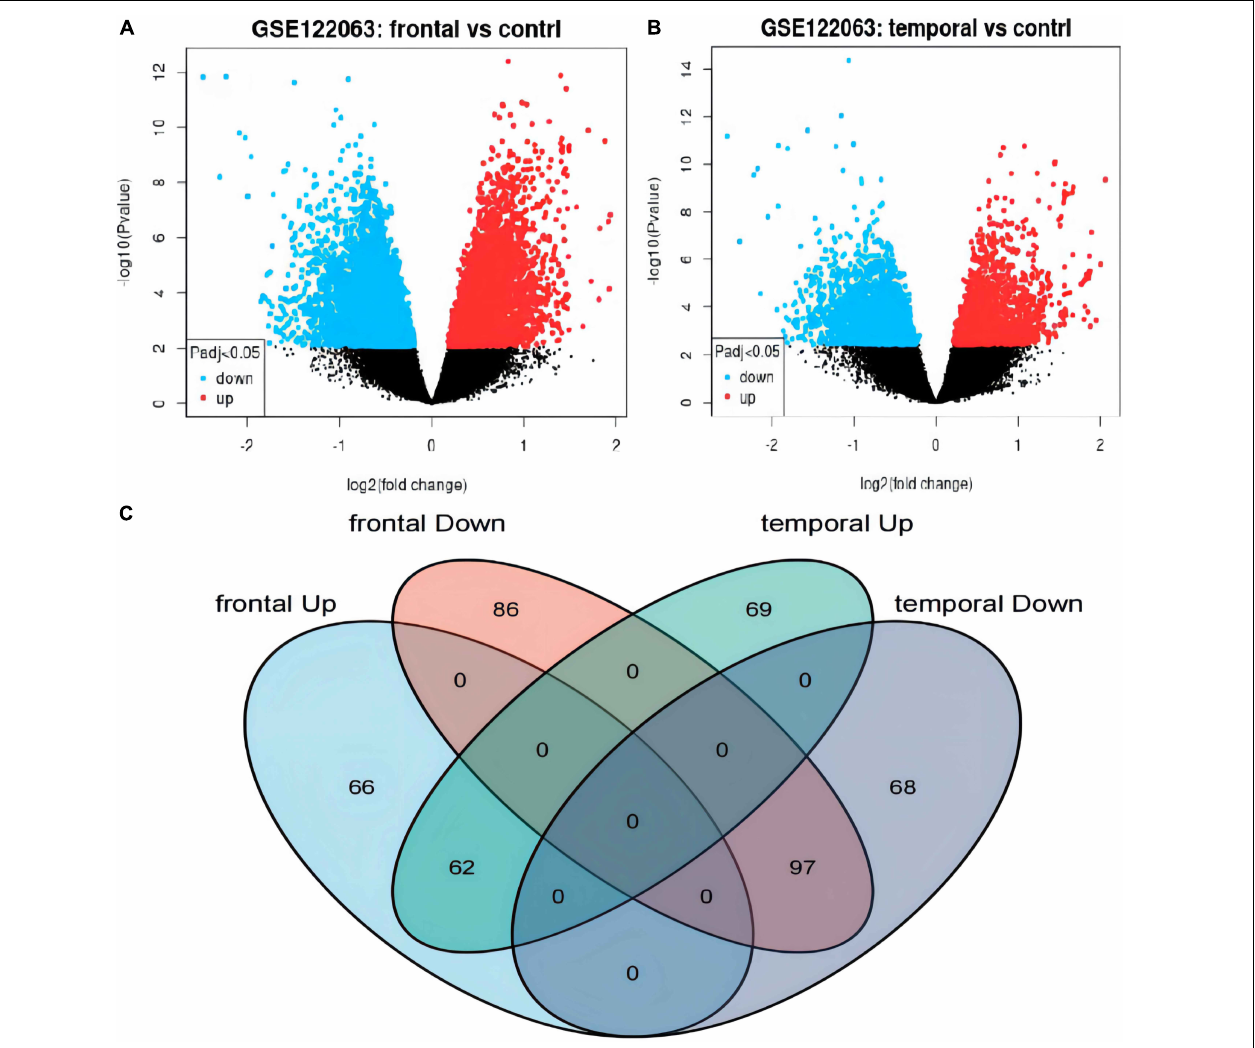
FIGURE 2 | Identification of differentially expressed genes (DEGs) in frontal cortex and temporal cortex in the vascular dementia microarray dataset GSE122063. (A,B) Volcano plots of DEGs in frontal cortex or temporal cortex of vascular dementia versus the controls. Blue indicates downregulated genes; red indicates upregulated genes; gray indicates genes that were not significantly differentially expressed. (C) Venn diagram showing the numbers of overlapping DEGs between the two brain regions.